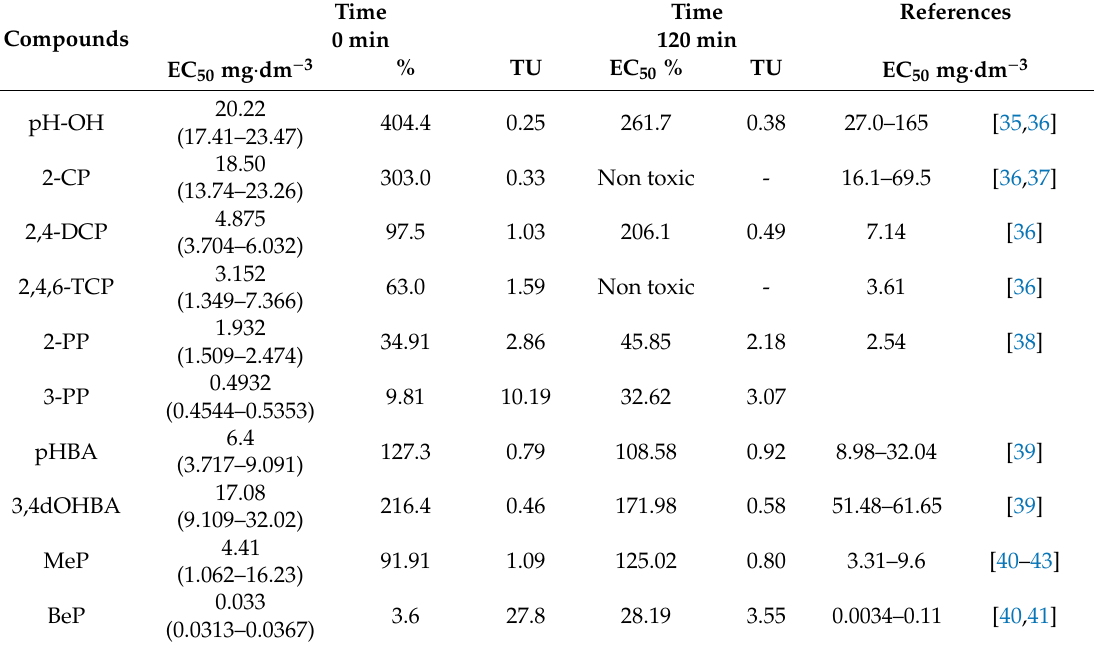
Table 4. The EC 50 values after 15 min and toxic units for the compounds tested before and after the photosensitized oxidation